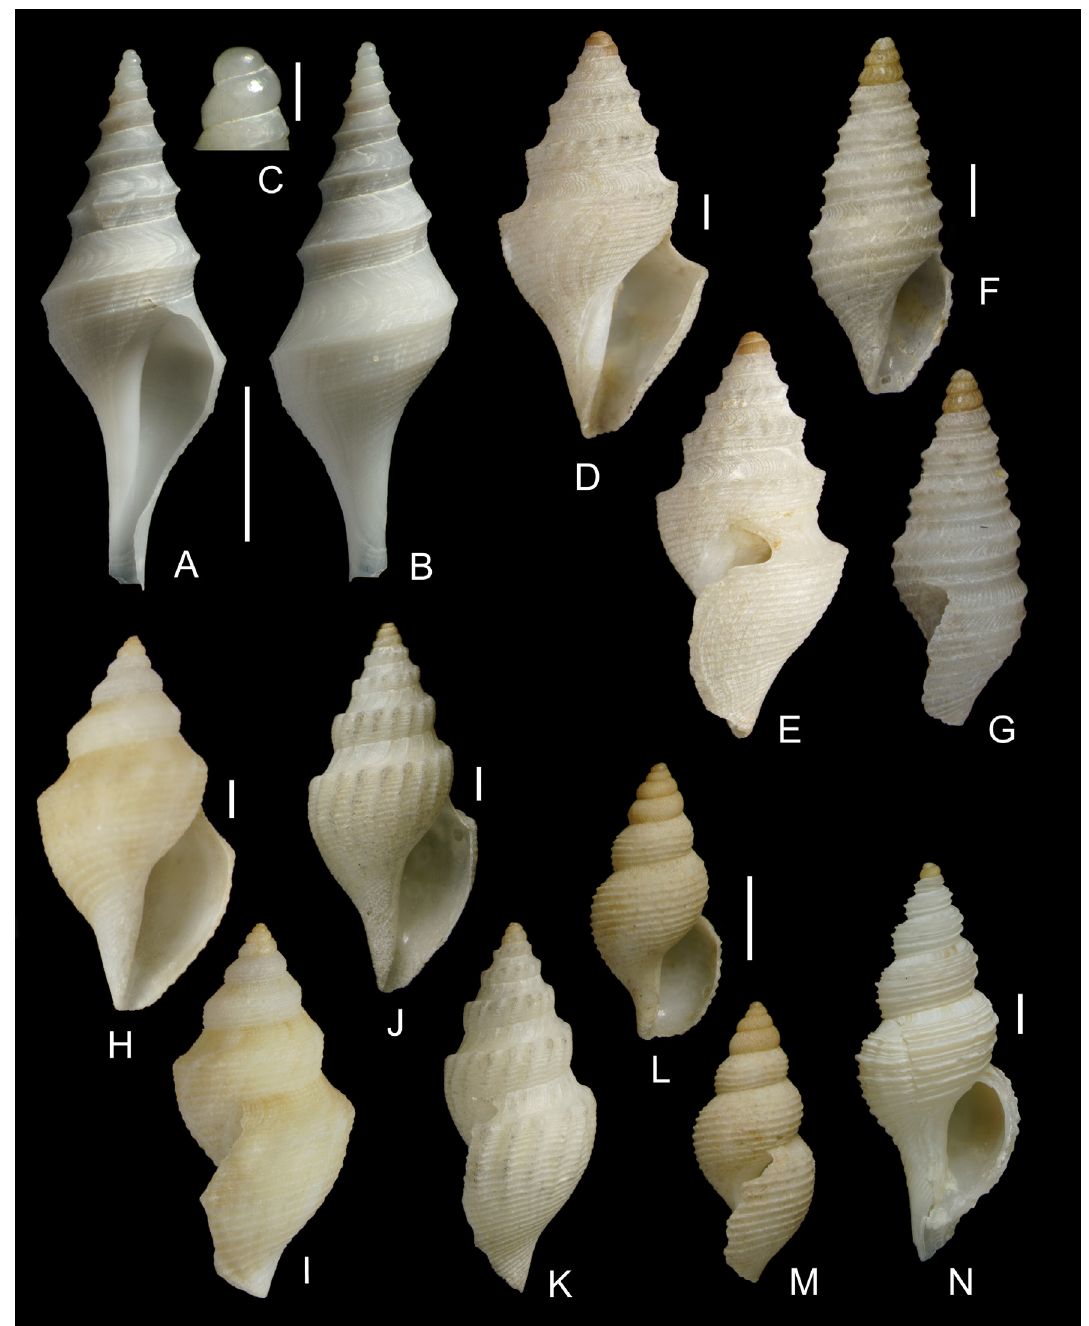
Fig. 26. Conoidea 1 (Cochlespiridae, Borsoniidae, Raphitomidae). A–C . Aforia serranoi